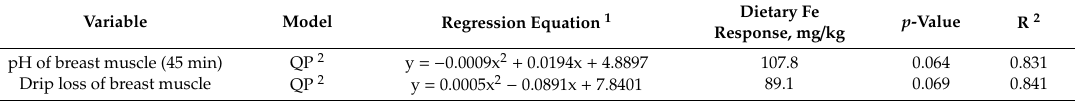
Figure 2. Drip loss of breast muscle (%) of broiler chicken fed diets supplemented with Fe. Regression equations obtained using the increasing dietary Fe in the current study (50, 70, 90, 110, 130 and 150 mg / kg). The quadratic polynomial (QP) regression (Y = 7.8401 – 0.0891 × X + 0.0005 × X 2 ; the minimum response arrow pointing at 89.1 mg / kg Fe, R 2 = 0.841, p = 0.069). Table 6. Dose response regressions for Chinese Yellow broilers fed diets with di ff erent Fe